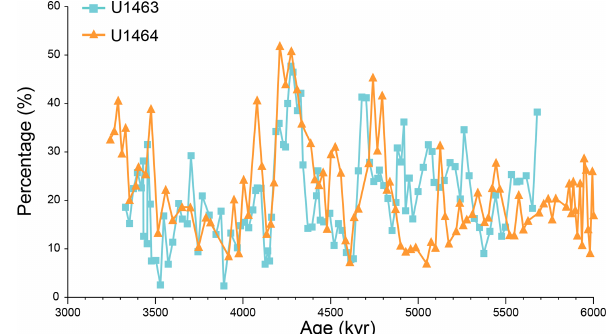
Figure A9. Relative abundances (%) of medium-sized (3–5µm) Reticulofenestra species plotted against sample age (kyr) at IODP Sites U1463 (blue squares) and U1464 (orange triangles). Distinct peaks (exceeding 40% of the assemblage) can be observed shortly before ( ∼ 4 . 7Ma) and after ( ∼ 4 . 3Ma) the 4.6–4.4Ma decrease in PP.